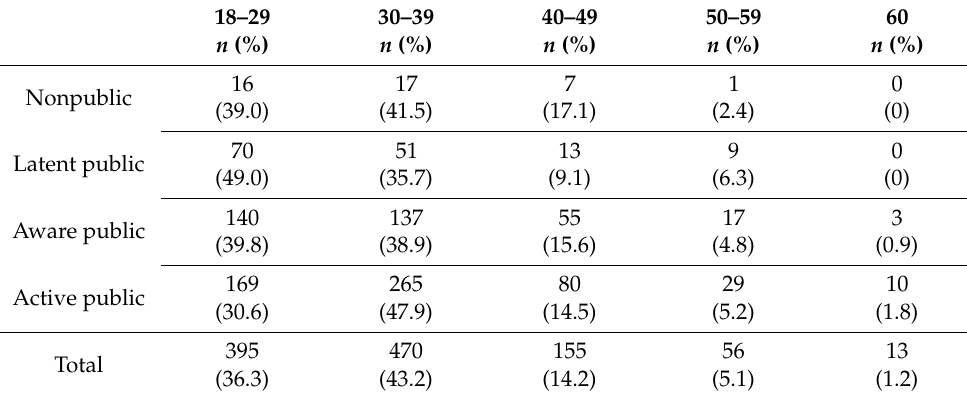
Table 4. Four types of publics and age in China.